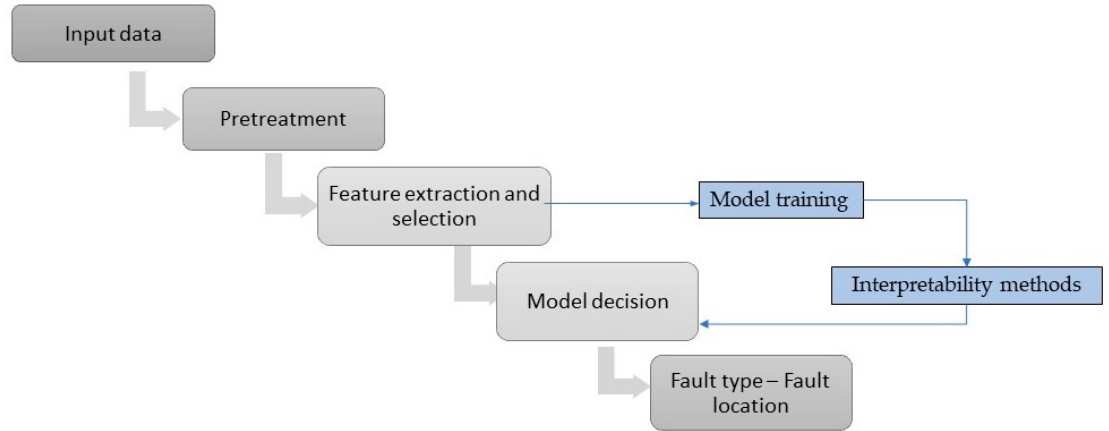
Figure 12. flowchart of ML fault diagnosis methods [114,118]. Figure 12. Flowchart of ML fault diagnosis methods